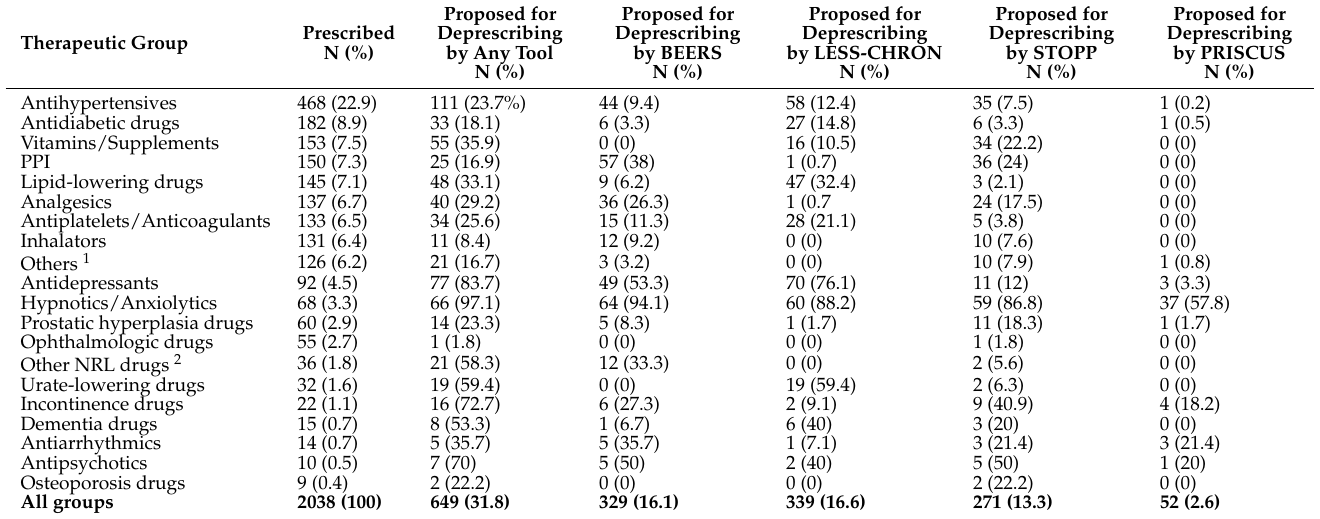
Table 3. Prescribed drugs per therapeutic group and drugs proposed for deprescribing per therapeutic